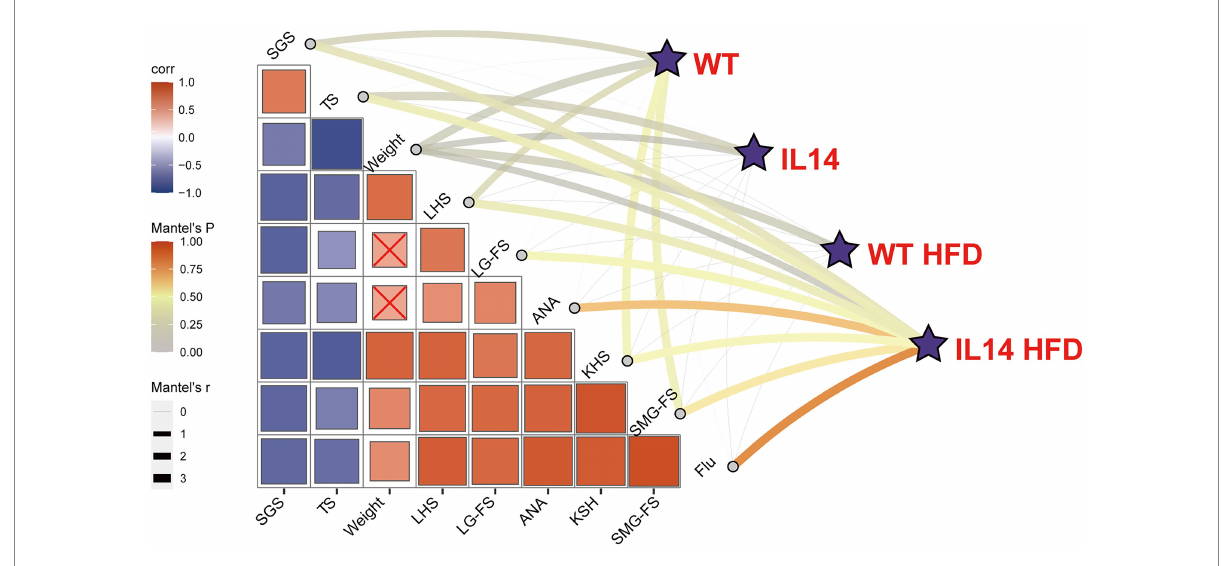
FIGURE 7 Correlation between gut microbiota and clinical parameters. The correlation between gut microbial communities (Bray-Curtis distance) and clinical parameters in different groups was analyzed with the Mantel tests. The edge width corresponds to the R -value, and the edge color denotes the statistical significance. The color gradient indicates Pearson correlation coefficients among the clinical parameters × indicates no significant correlation at the 0.05 level. SGS, salivary gland secretions; TS, tear secretions; LHS, lung histologic score; LG-FS, lacrimal gland focus score; ANA, antinuclear antibodies; KHS, kidney histologic score; SMG-FS, submandibular gland focus score; and Flu, fluorescein staining